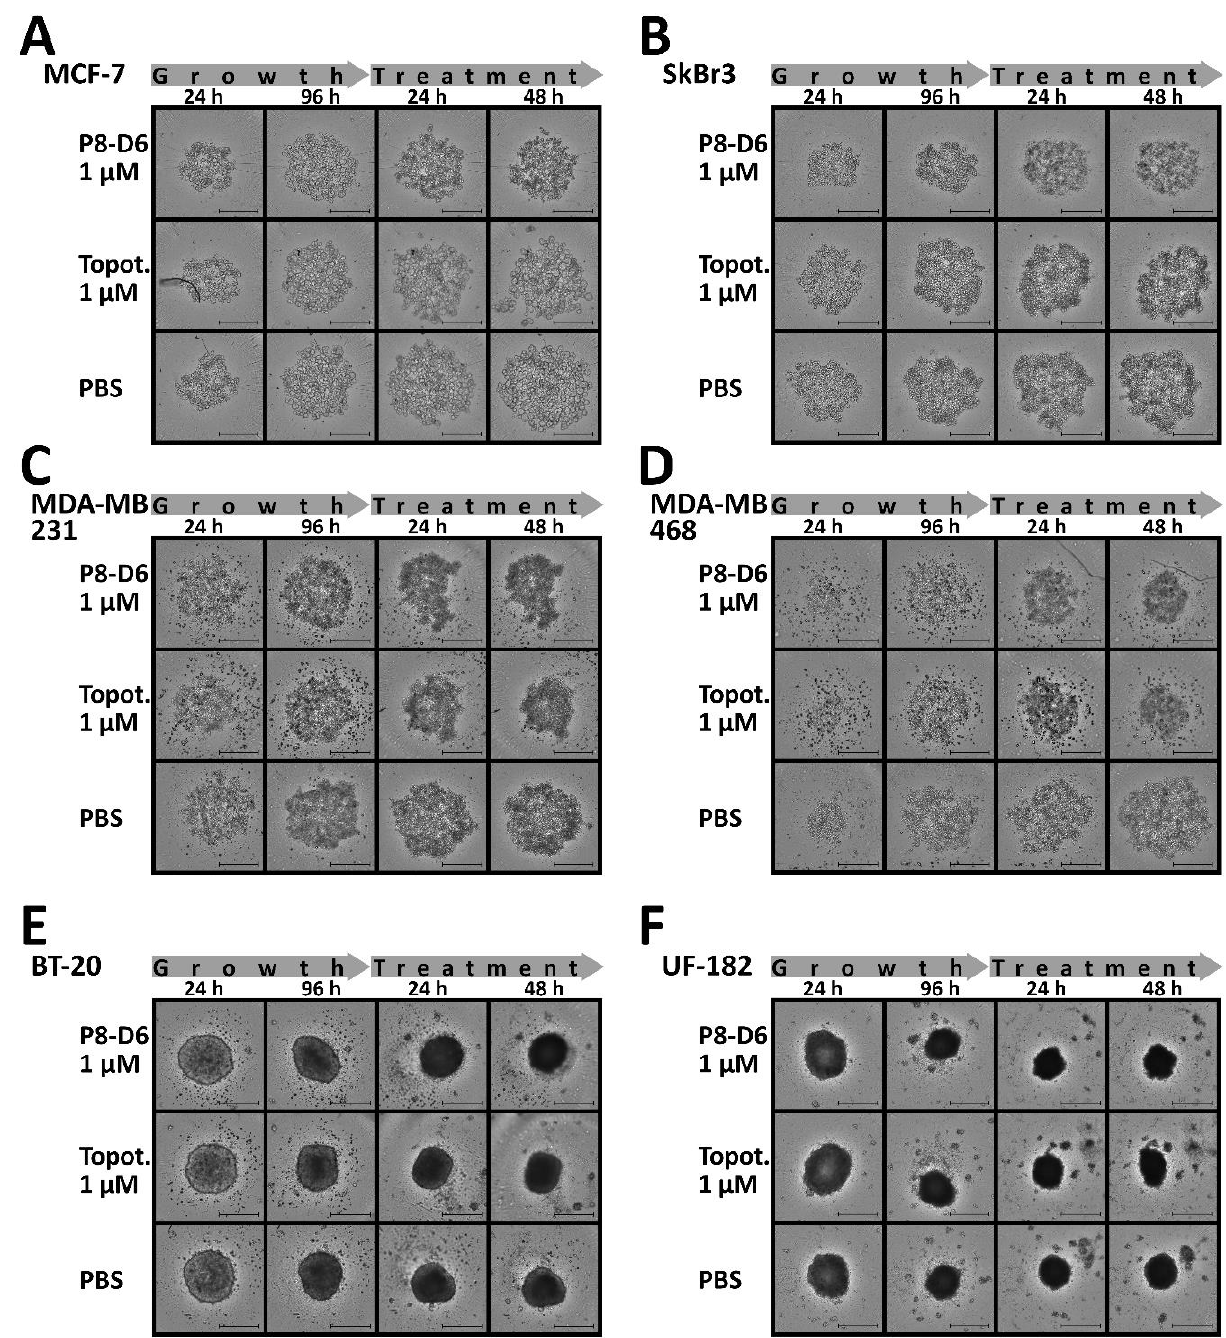
Figure 4. Growth changes in BC spheroids. For 3D culture, MCF-7, SkBr3, MDA-MB231, MDA- MB468, BT-20 (cell line) and UF-182 (primary cells) cells were cultured in ULA plates for 96 h. Subsequently, spheroids were treated with P8-D6 (10 µ M, 1 µ M, 0.5 µ M, 0.1 µ M), topotecan (10 µ M, 1 µ M) and PBS for 48 h. For the monitoring of growth changes and morphological changes, spheroids were imaged every 24 h by microscopy. MCF-7 ( A ), SkBr3 ( B ), MDA-MB231 ( C ), MDA-MB468 ( D ), BT-20 ( E ) and UF-182 ( F ). Scale bars, 500 µ